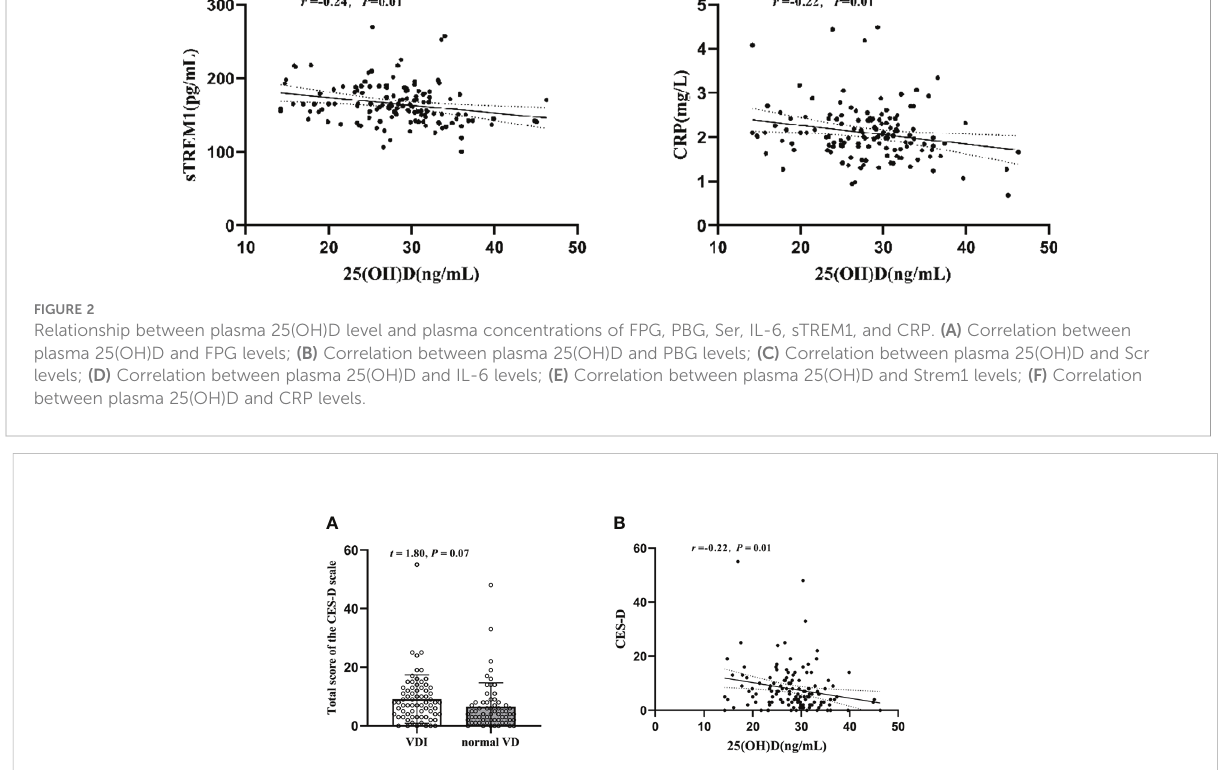
FIGURE 3 Changes of the CES-D sum scores in T2DM patients and their relation with plasma 25(OH)D level. (A) The CES-D sum scores in 25(OH)D<29 (ng/mL) and HbA1c ≥ 29(ng/mL); (B) Correlation between plasma 25(OH)D level and CES-D sum